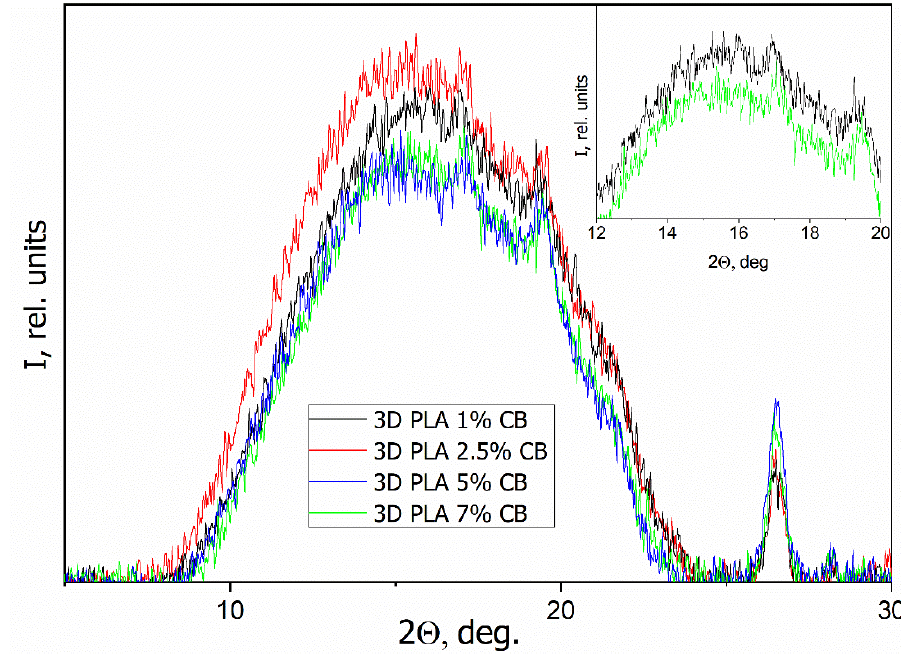
Figure 13. WAXS patterns of the 3D specimens, obtained from the composite filaments with various CB content φ , inset in the figure shows patterns for PLA/CB composites with 5 and 7 vol.% of